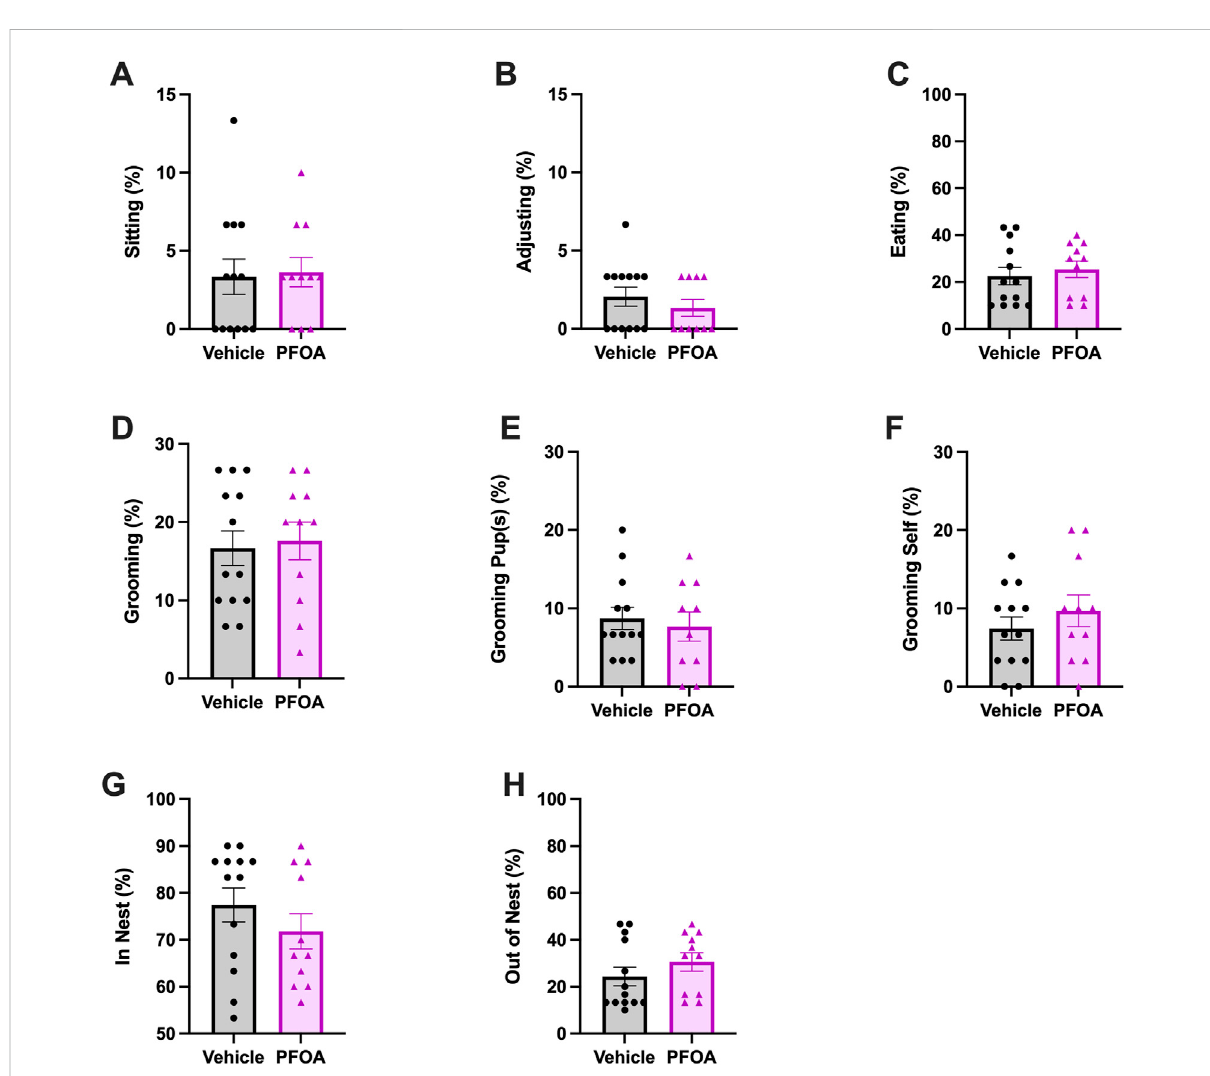
FIGURE 3 Maternal Behavior Averages. The average activity of each maternal behavior sitting (A) , adjusting (B) , eating (C) , grooming (D) , grooming pup(s) (E) , grooming self (F) , innest (G) , and out ofnest (H) scored over thecourse ofpostnatal days 5 – 9. Data represented as mean ± standard error of the mean, n = 10-11/PFOA and n = 13/vehicle. Data analyzed with two-sided student ’ s